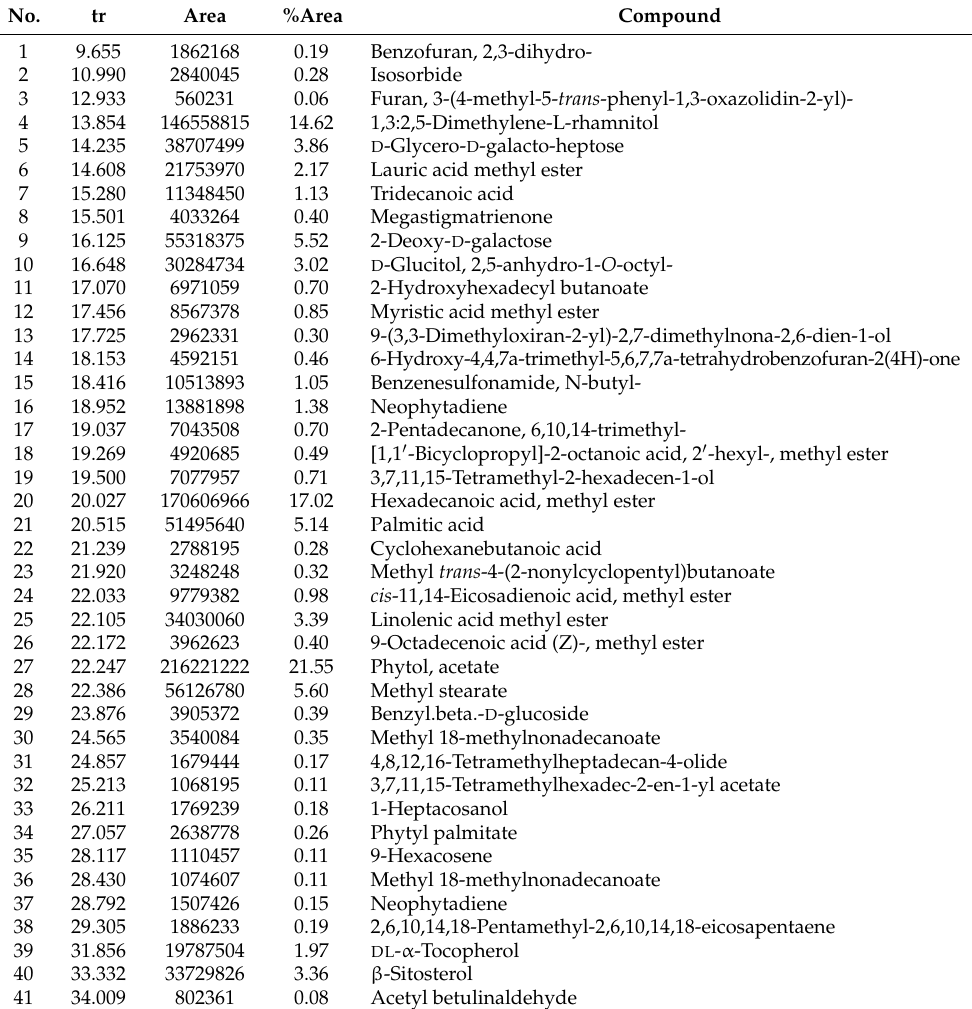
Table 5. Composition of the extracts of leaves of C. hsingshangensis (% of total fraction; mass%, GC).